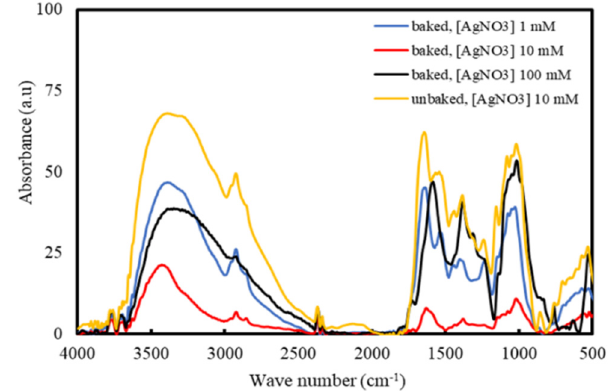
Figure 7. FTIR spectra of the colloidal samples.